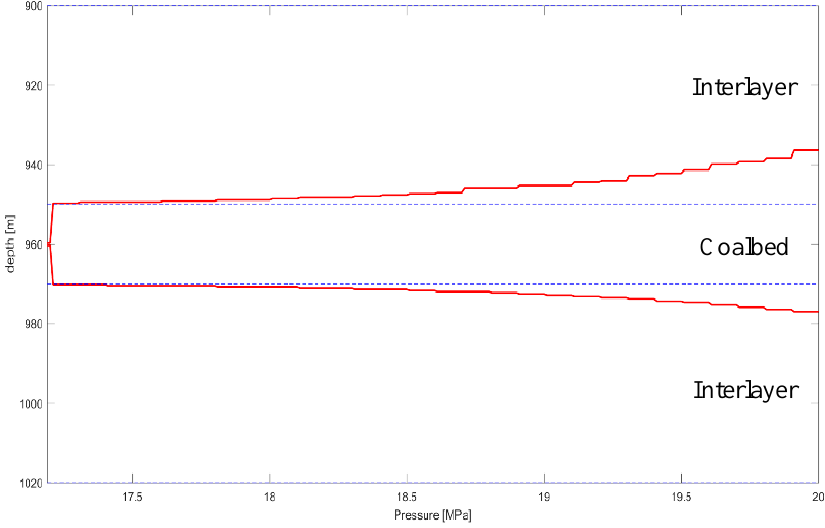
Figure 5. The changes of fracture height with injection pressure at the perforation.